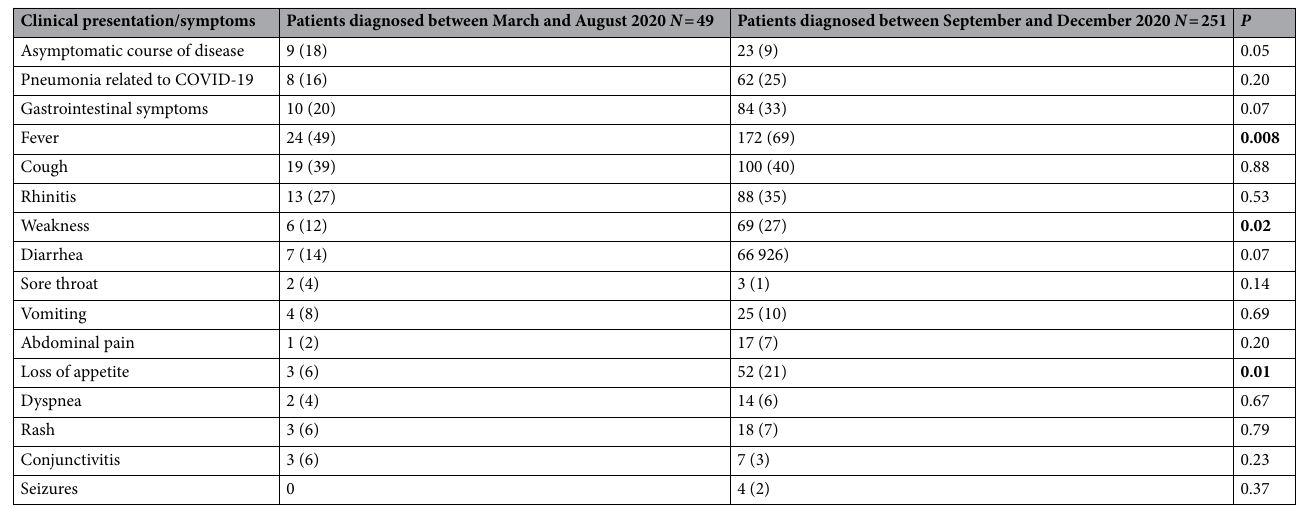
Table 3. Clinical presentation of infants with COVID-19 during the 1st and 2nd waves of the pandemic. Data are presented as numbers (%). Significance values are in